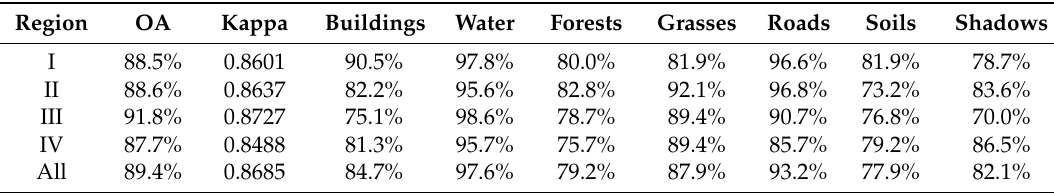
Table 3. Classification accuracies of the proposed method in the four test regions in terms of overall accuracy (OA), Kappa coefficient, and F1-score for each